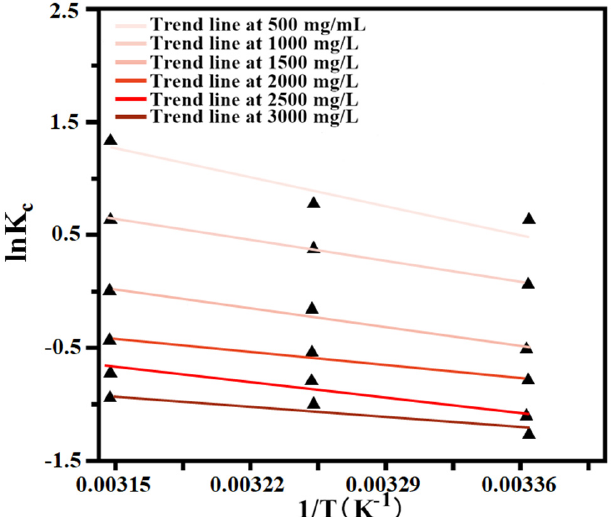
Figure 7. The linear plot of ln(K c ) to 1/T response to PILs absorbing of EGCG. Table 5. Thermodynamic parameters of the adsorption EGCG on PILs.